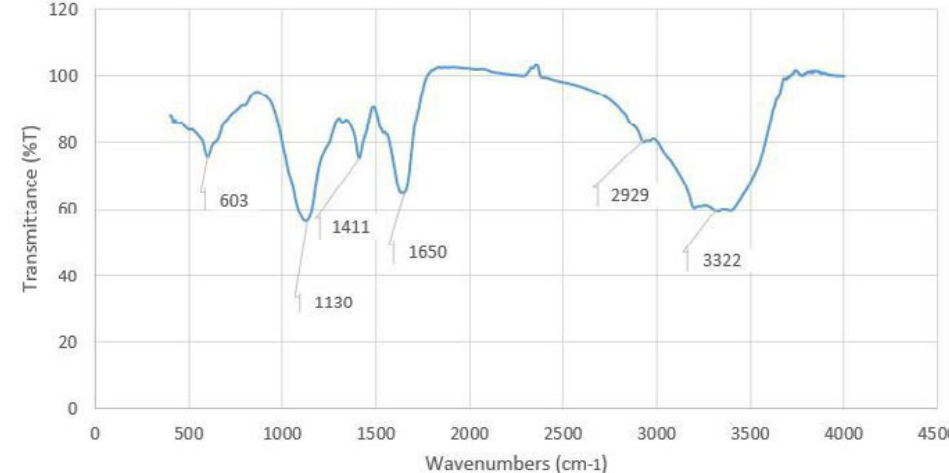
Fig. 5. FTIR spectra of palladium oxide Fig 5. FTIR spectra of palladium oxide nanoparticles